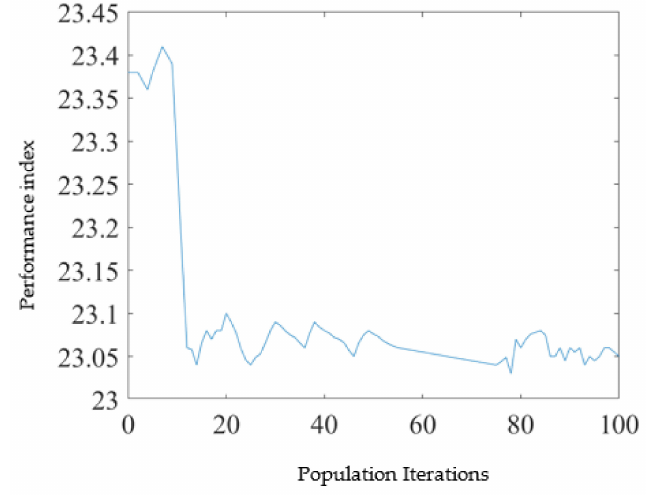
Figure 14. Iteration results of optimal population of genetic algorithm.